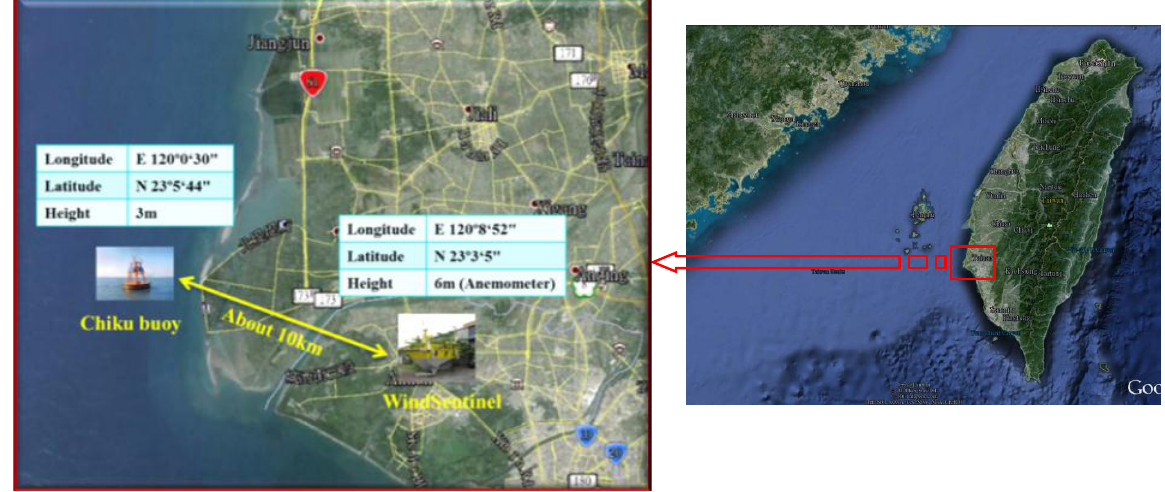
Figure 4. Locations of the Qigu buoy and Lidar system in the Tainan